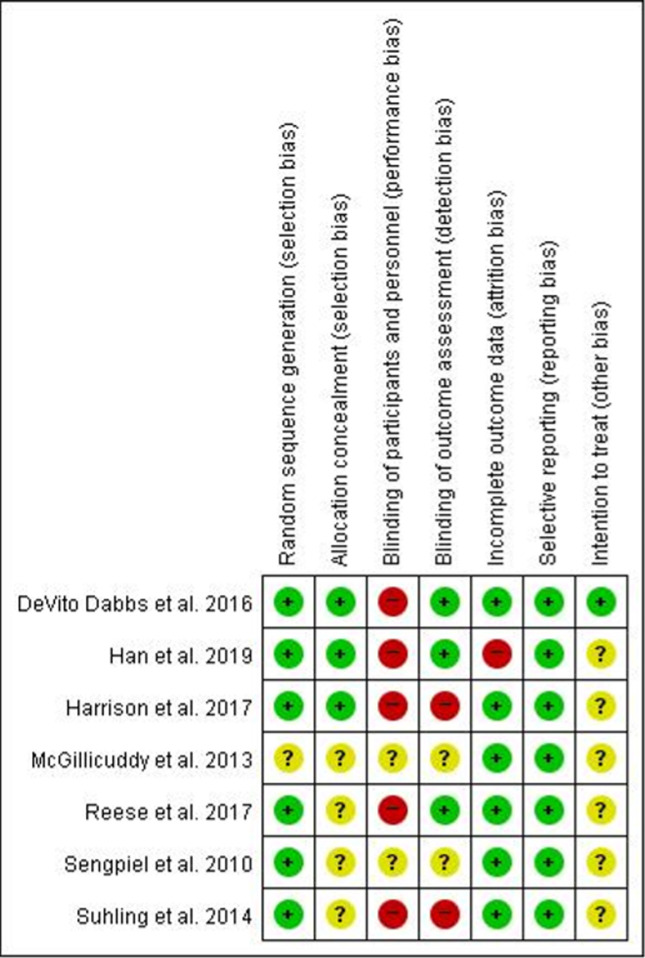
Risk of bias summary.